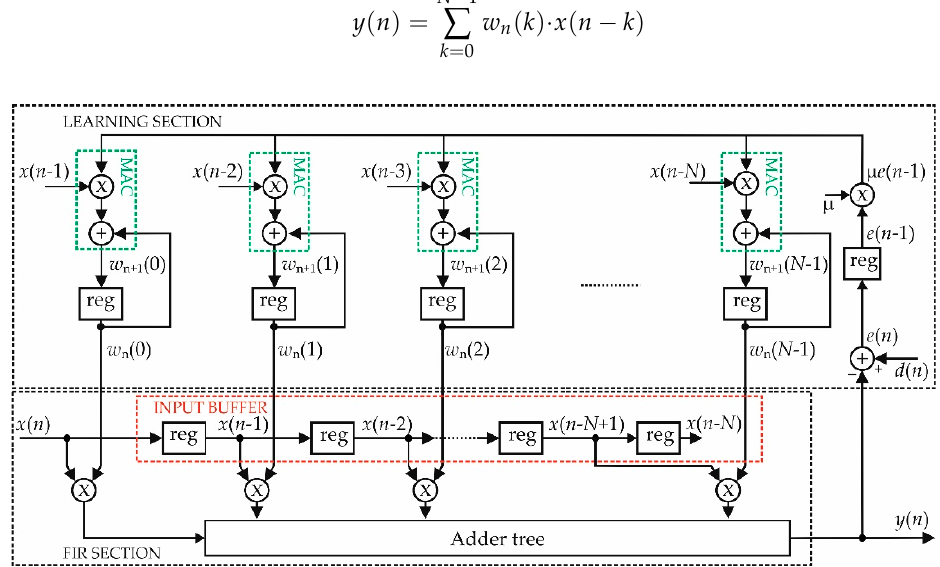
Figure 2. Block diagram of the DLMS filter.